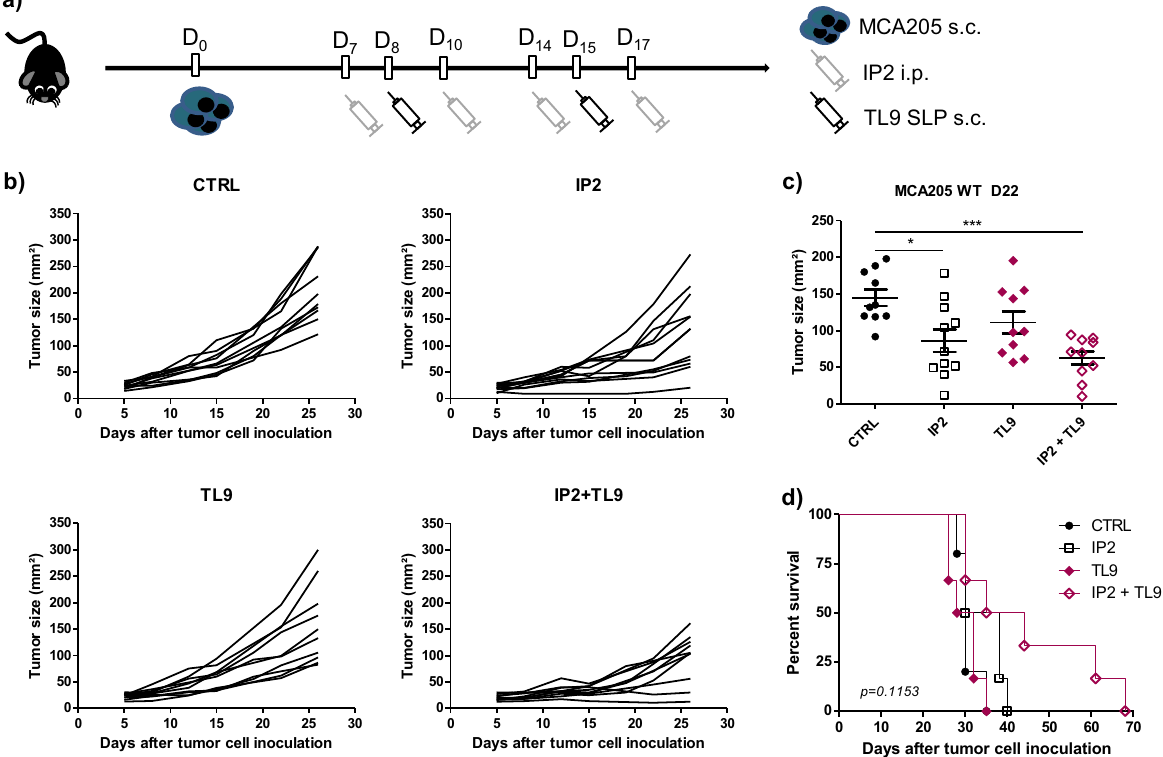
Fig. 7 IP2 treatment and a therapeutic cancer vaccine targeting the nischarin-derived epitope synergize to inhibit tumor growth. a Experimental setting for the evaluation of the antitumor activity of IP2 in combination with the therapeutic TL9 SLP vaccine. b Individual tumor growth kinetics and ( c ) tumor size at killing of MCA205 fi brosarcoma subcutaneously inoculated into the right fl ank of immunocompetent C57BL/6 mice and thereafter injected once a week with the TL9 SLP and twice a week with 24 mg/kg of IP2. d Kaplan – Meier survival curves of MCA205 fi brosarcoma-bearing immunocompetent C57BL/6 treated concomitantly with the TL9 SLP and 24 mg/kg of IP2 for 2 weeks. Log-rank (Mantel – Cox) test were performed for survival analysis. * P < 0.05, *** P < 0.001 (One-way